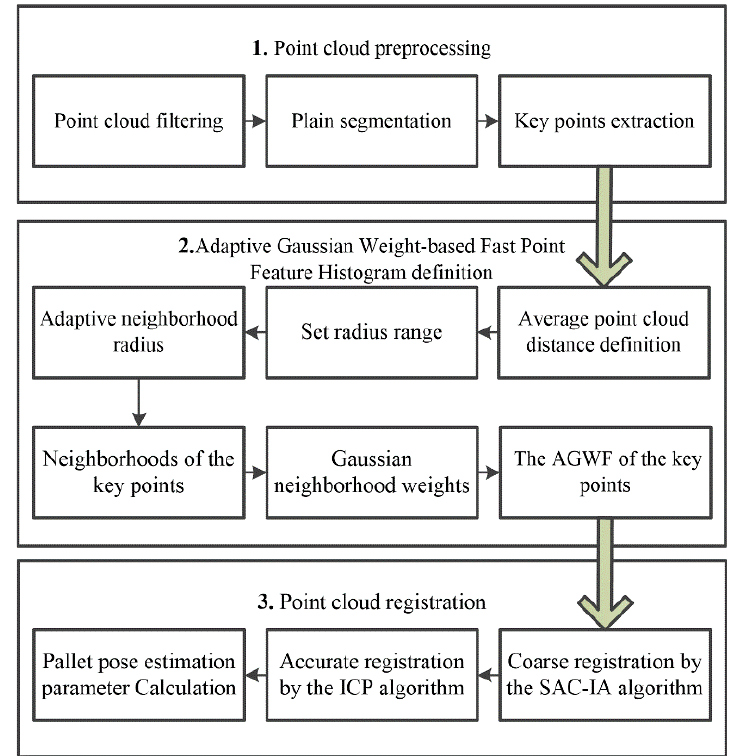
Figure 2. Flowchart of the pallet pose estimation method.